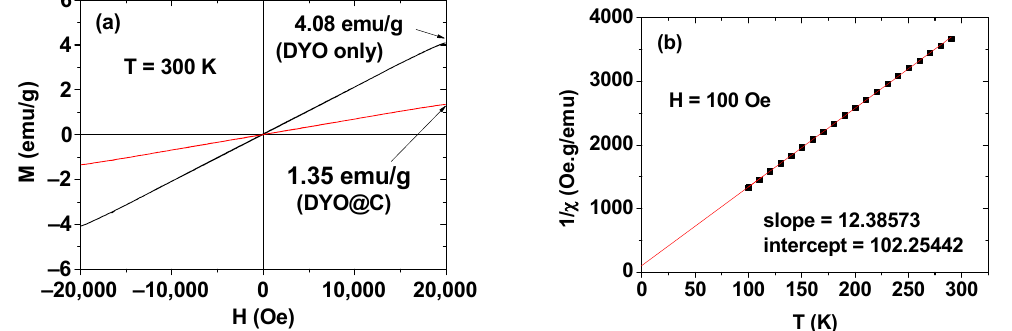
Figure 5. Magnetic properties of DYO@C nanoparticles. ( a ) M–H curves before and after mass correction at 300 K and ( b ) plot of the Curie–Weiss law using the mass-corrected M. The mass correction of M was done using the net mass of DYO nanoparticles obtained from TGA.